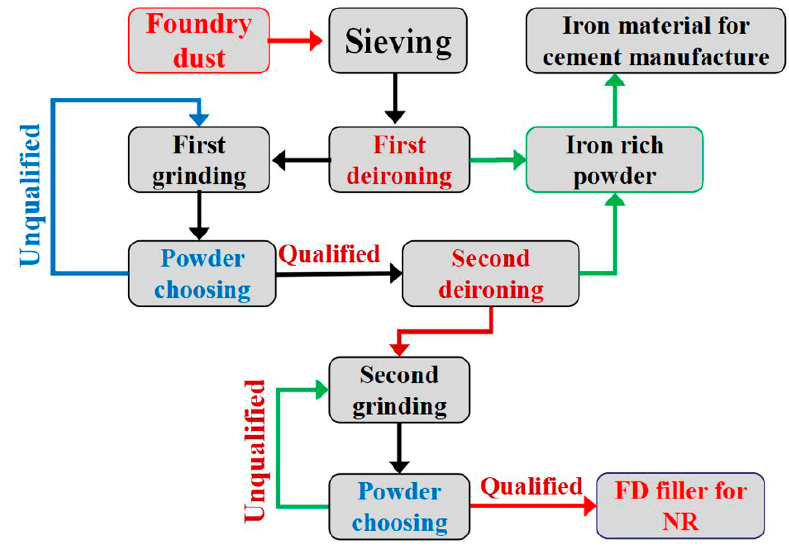
Figure 1. Schematic diagram of processing foundry dust derived fillers.